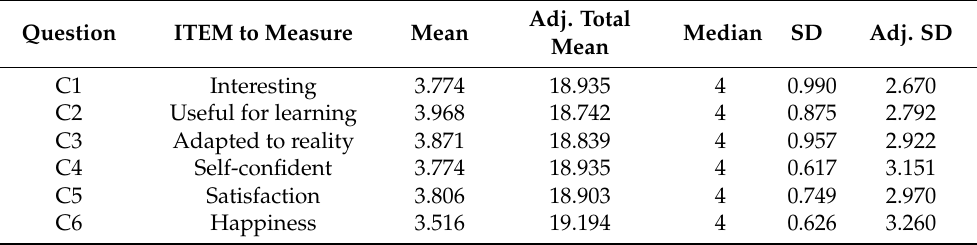
Table 5. Results for each raised